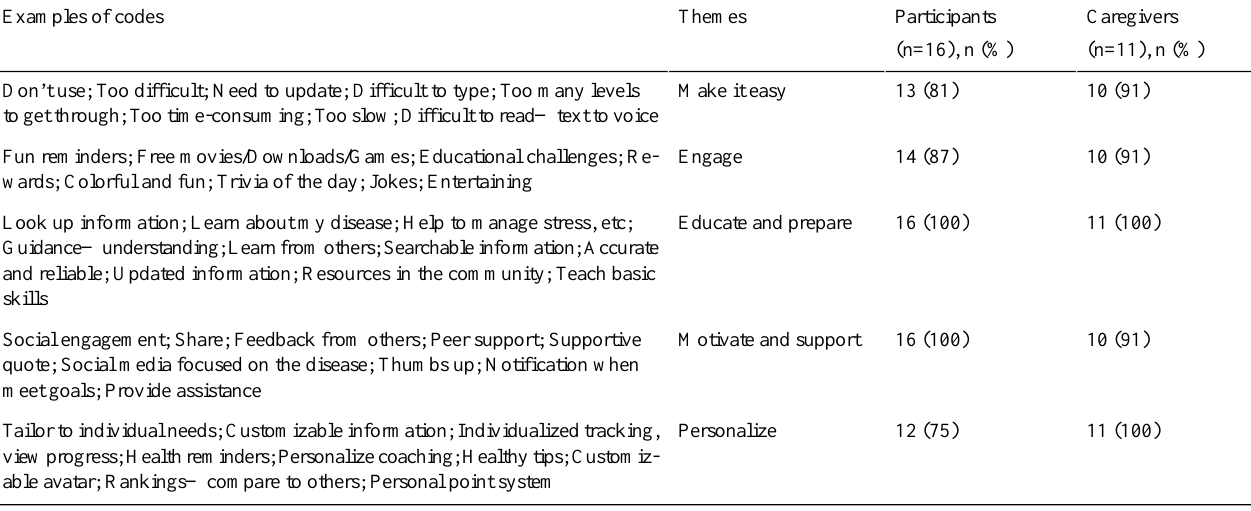
Table 2. Examples of codes, developed themes, and prevalence of overall participant/caregiver